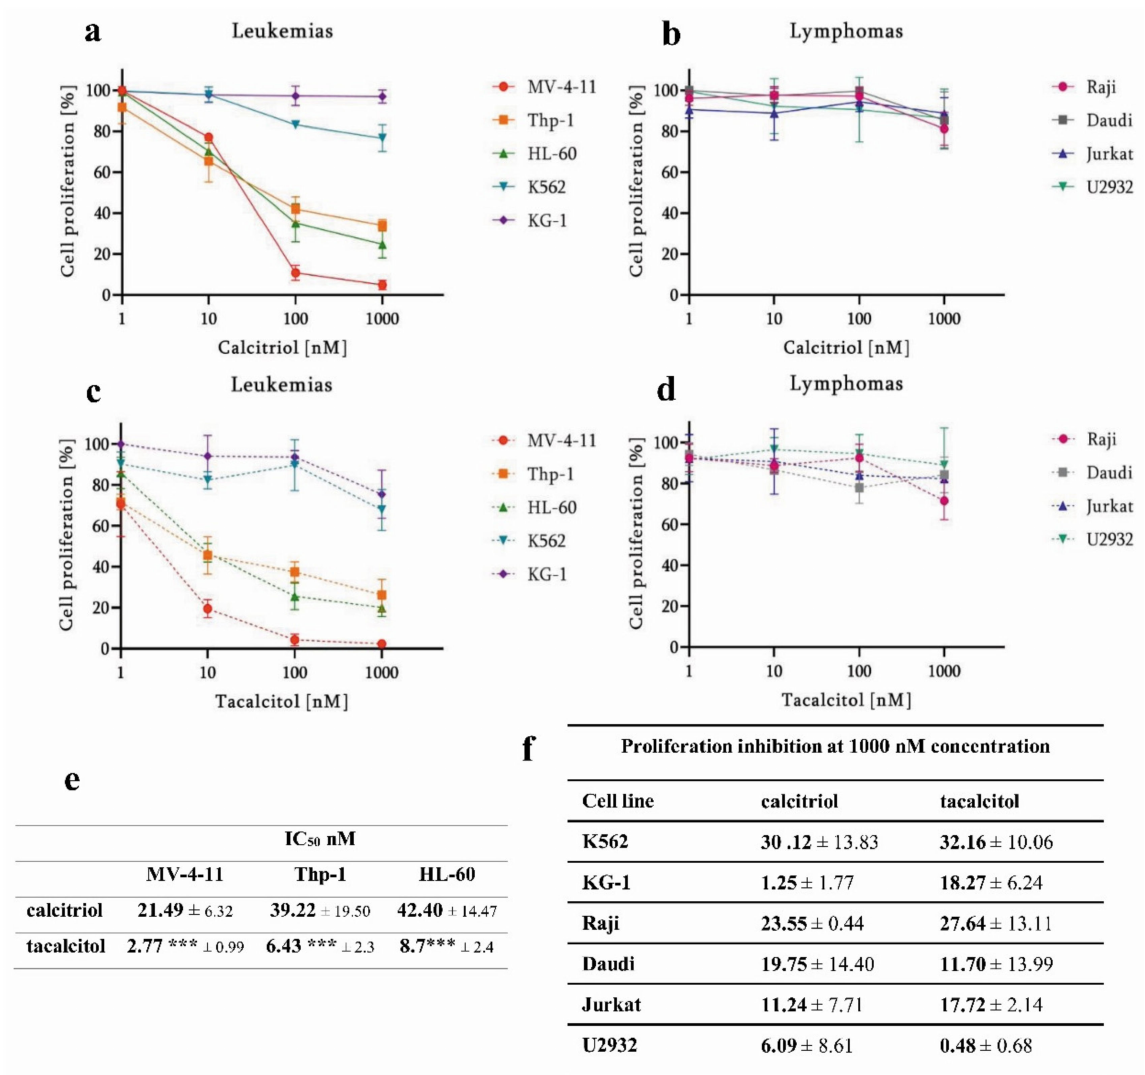
Figure 1. In vitro antiproliferative activity of calcitriol and tacalcitol against myeloid cancer cells. 1–1000 nM calcitriol ( a , b ) and tacalcitol ( c , d ) dose-out after 120 h exposure. Three cell lines: MV-4-11 acute myelomonocytic leukemia, Thp-1 acute monocytic leukemia and HL-60 acute myelocytic leukemia, showed high sensitivity to calcitriol and tacalcitol. The IC 50 value of tested compounds in nM concentration (mean ± standard deviation). *** p < 0.05 as compared to calcitriol; Statistical analysis: Kruskal–Wallis multiple comparison test ( e ). The percent inhibition of proliferation after 1000 nM treatment is presented (mean ± standard deviation) ( f